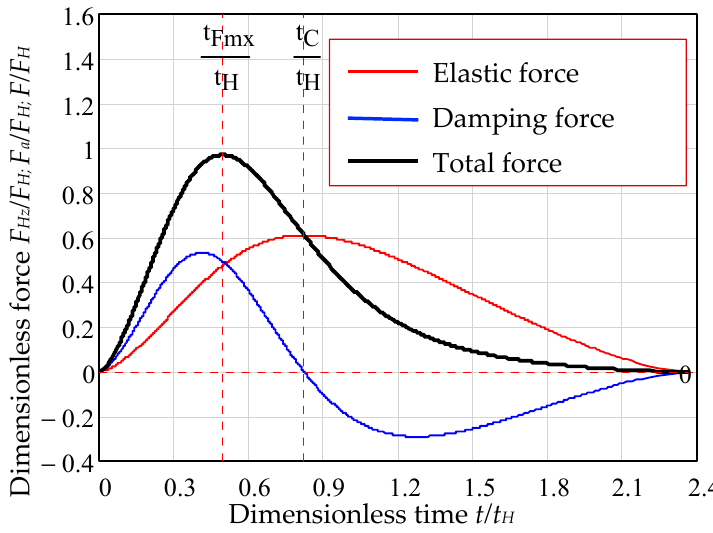
20 of 32 Figure 14. Variation of velocity with time.